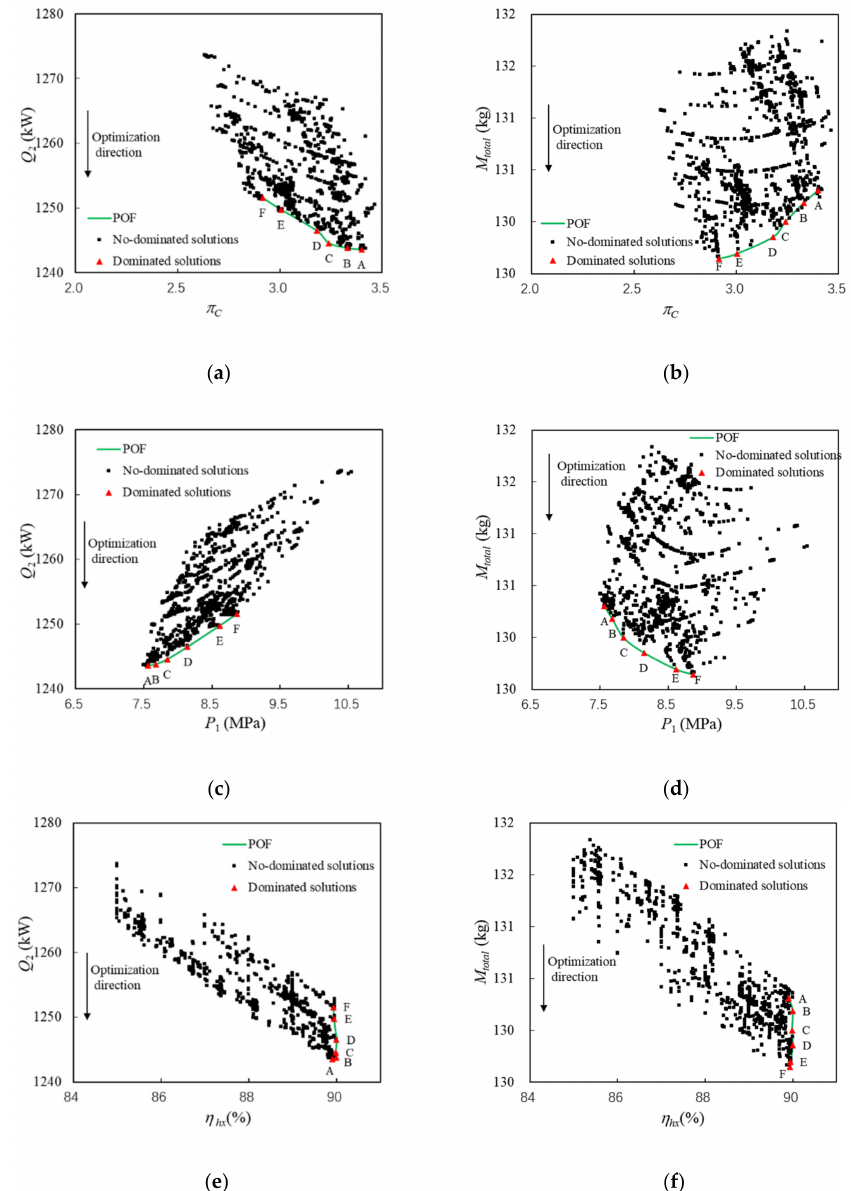
Figure 11. Relationships between optimization variables and optimization objectives. ( a ) π C and Q hs